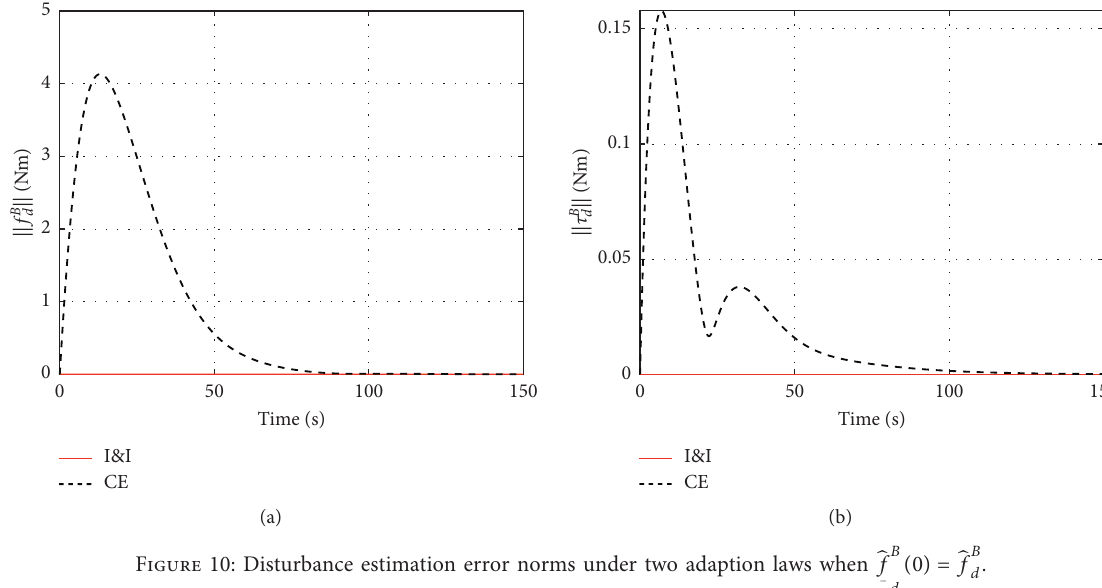
Figure 10: Disturbance estimation error norms under two adaption laws when 􏽢 f